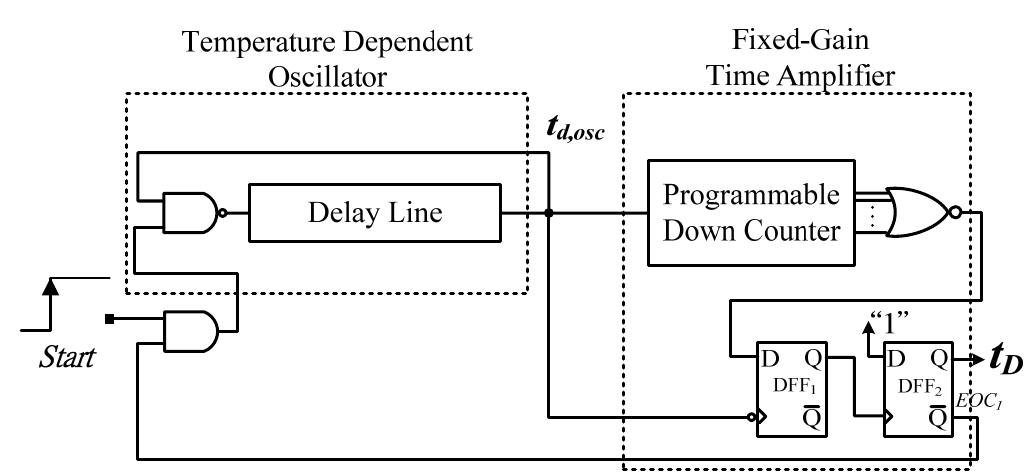
Figure 4. Block diagram of the